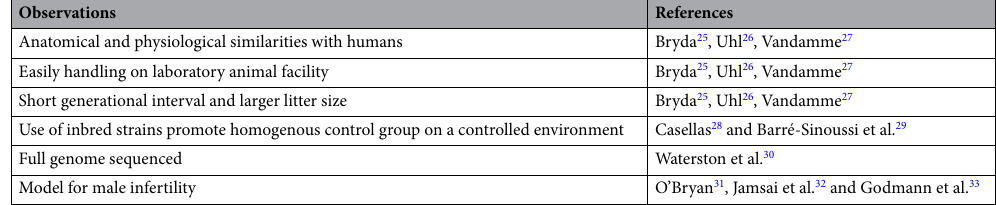
Table 1. Summary of advantages for use murine as a model in scientific research.